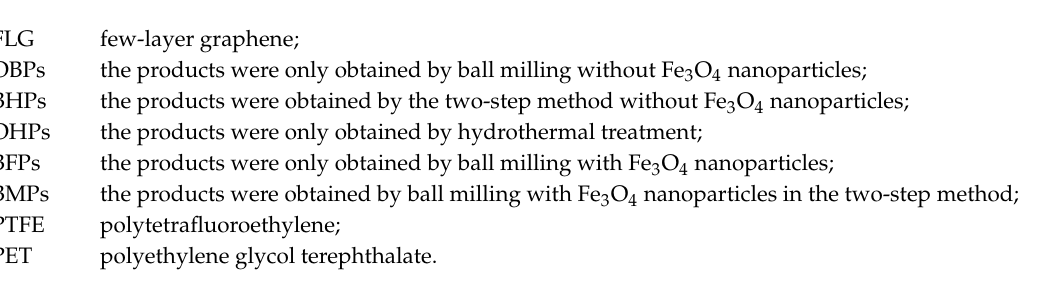
Table S1. Experimental conditions for preparation of graphene, Table S2. A comparison between di ff erent ball-milling and hydrothermal treatment methods of producing few-layered graphene in terms of the production yield and / or the amount of graphite / graphene, using the data available in the literature, Table S3. Number of layers (NG) for FLG, Table S4. Sheet resistance of the PTFE and PET film measured by M3, Figure S1: TEM and HRTEM images of the BFPs, Figure S2. a: AFM images of the BFPs, Figure S3. SEM images of the powders; Figure S4. a: TEM images of the OBPs, b: TEM images of the BHPs, c: TEM images of the BFPs, d: TEM images of the FLG nanosheets, Figure S5. AFM image of the obtained products, Figure S6. Flake thickness distribution measured using AFM analysis of the FLG nanosheets., Figure S7. Image of the FLG nanosheets in pure water with the concentration of 20 mg / mL to 0.04 mg / mL., Figure S8. SEM images of the powders; a-b: A4 paper, e-f: PET, c-d: PTFE with the BFPs, g-h: PTFE with the FLG